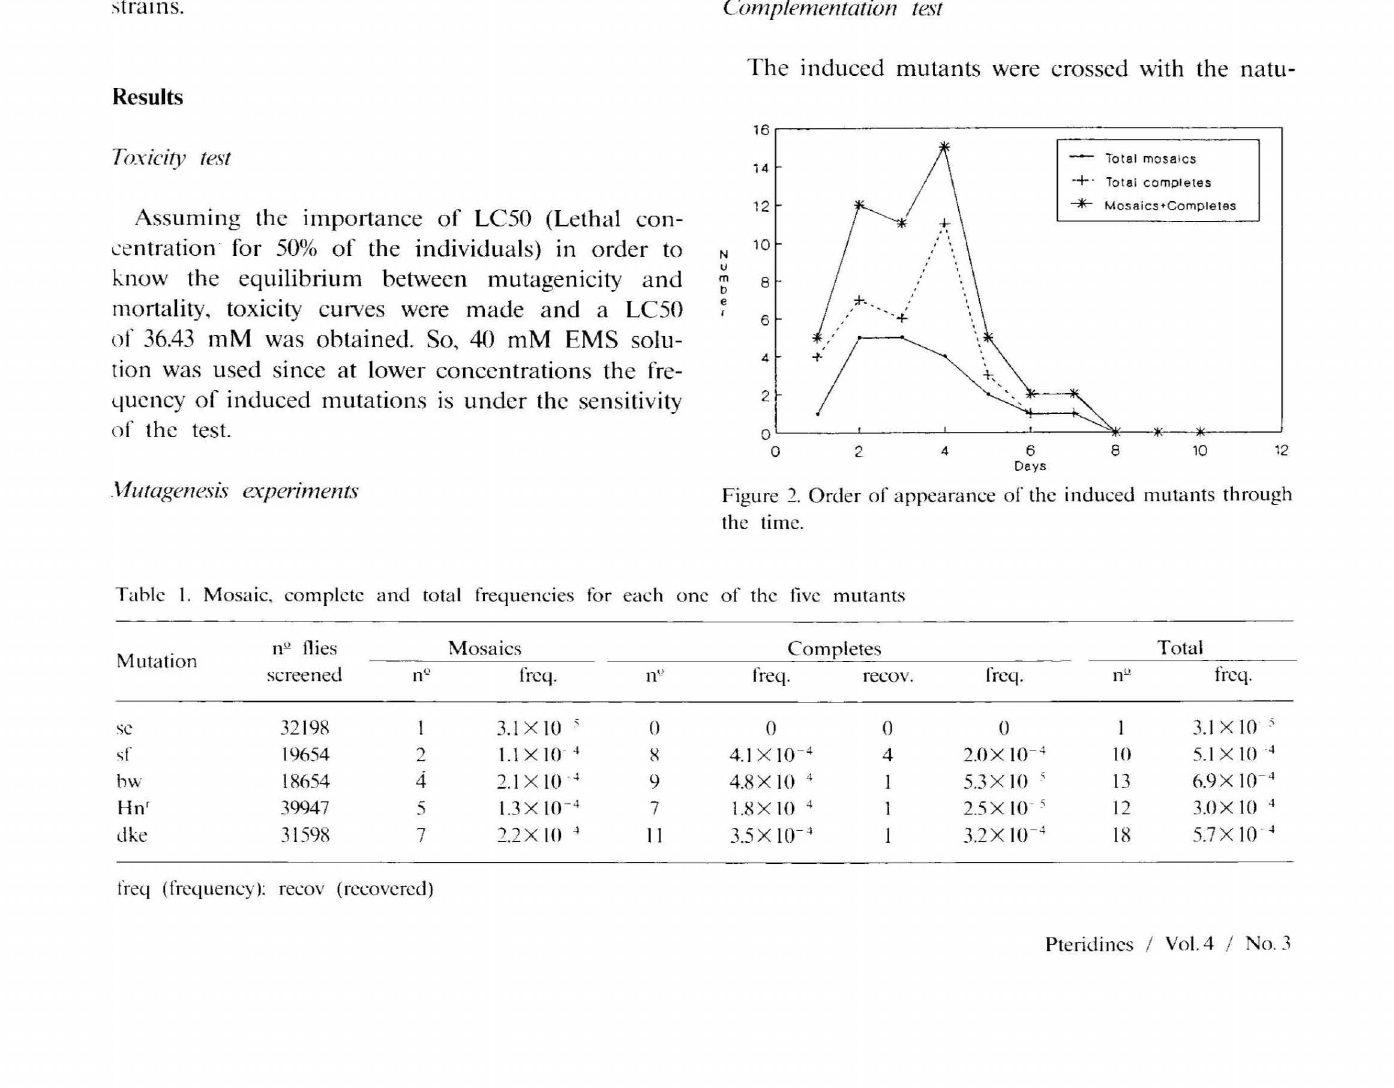
Table I. Mosaic. complete and total frequencies for each one nil flies Mosaics Mutation